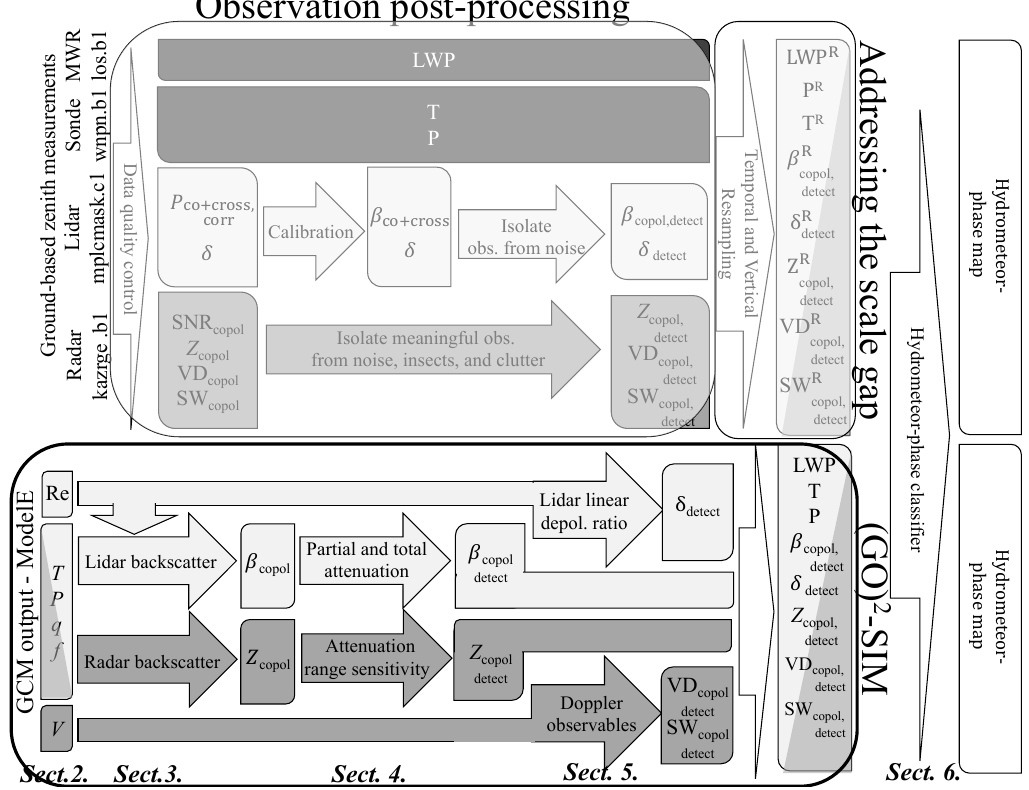
Figure 1. (GO) 2 -SIM framework. (GO) 2 -SIM emulates two types of remote sensors: Ka-band Doppler radars (dark gray shading) and 532nm polarimetric lidars (light gray shading). It then tunes and applies a common phase-classification algorithm (white boxes) to both observed (upper section) and forward-simulated (bottom section) fields. Follow-on work will describe how observation can be post-processed and resampled to reduce the scale gap before model evaluation can be